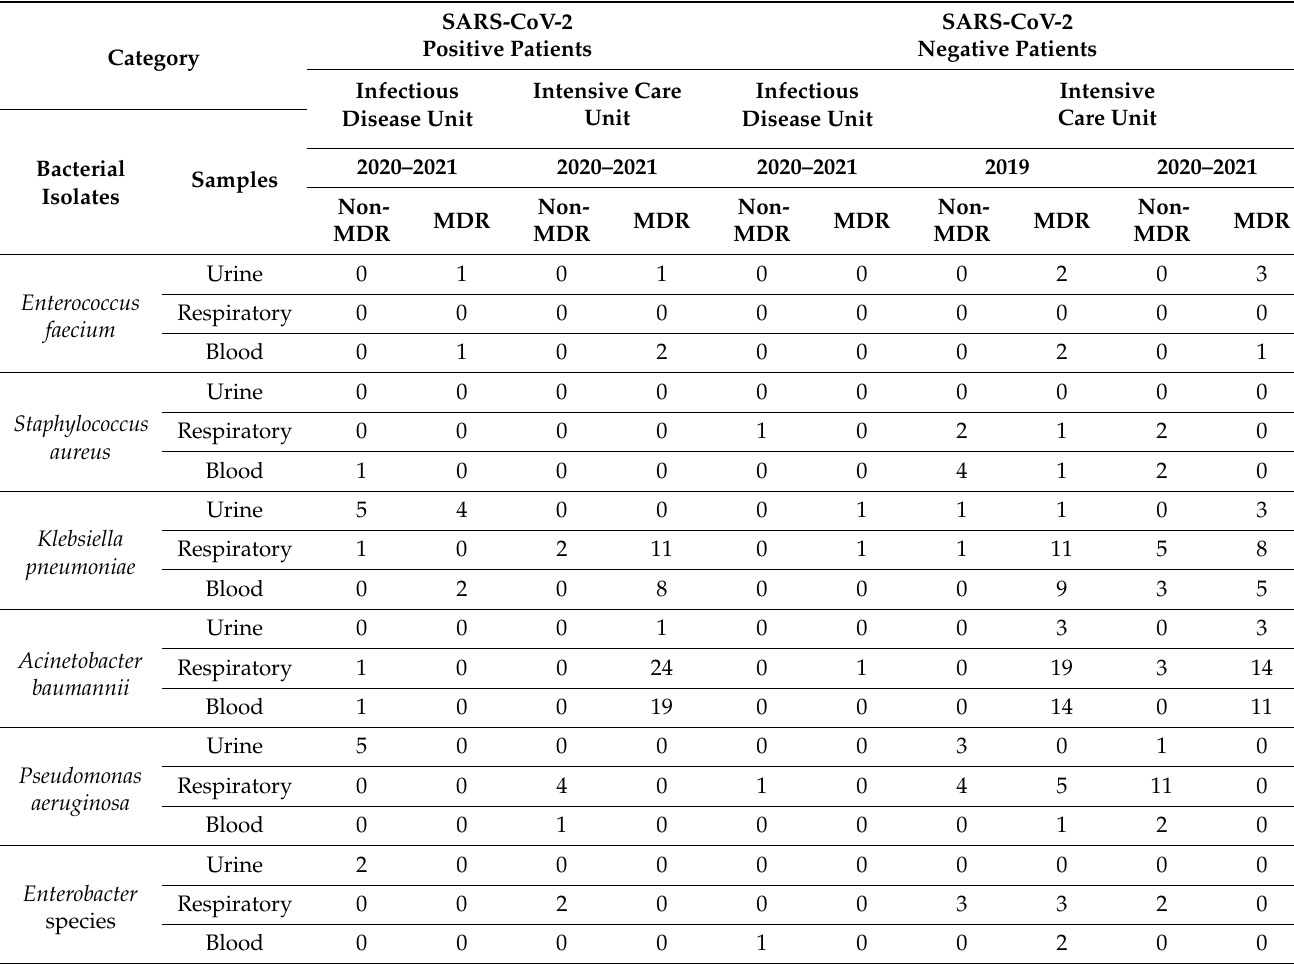
Table 1. Distribution of bacterial isolates by hospital units and samples in COVID-19 and non-COVID- 19